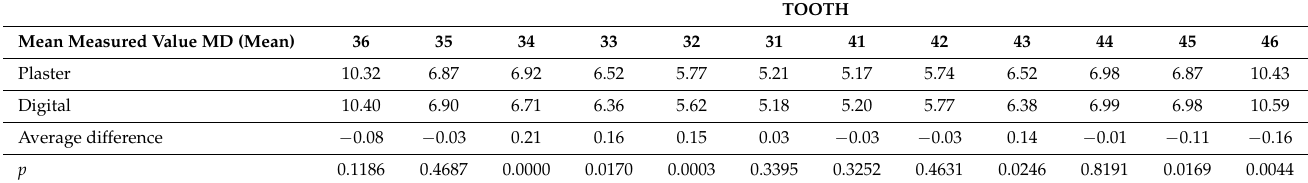
Table 2. Comparison of the mean values of the tooth width (MD) measurements in the lower arch.